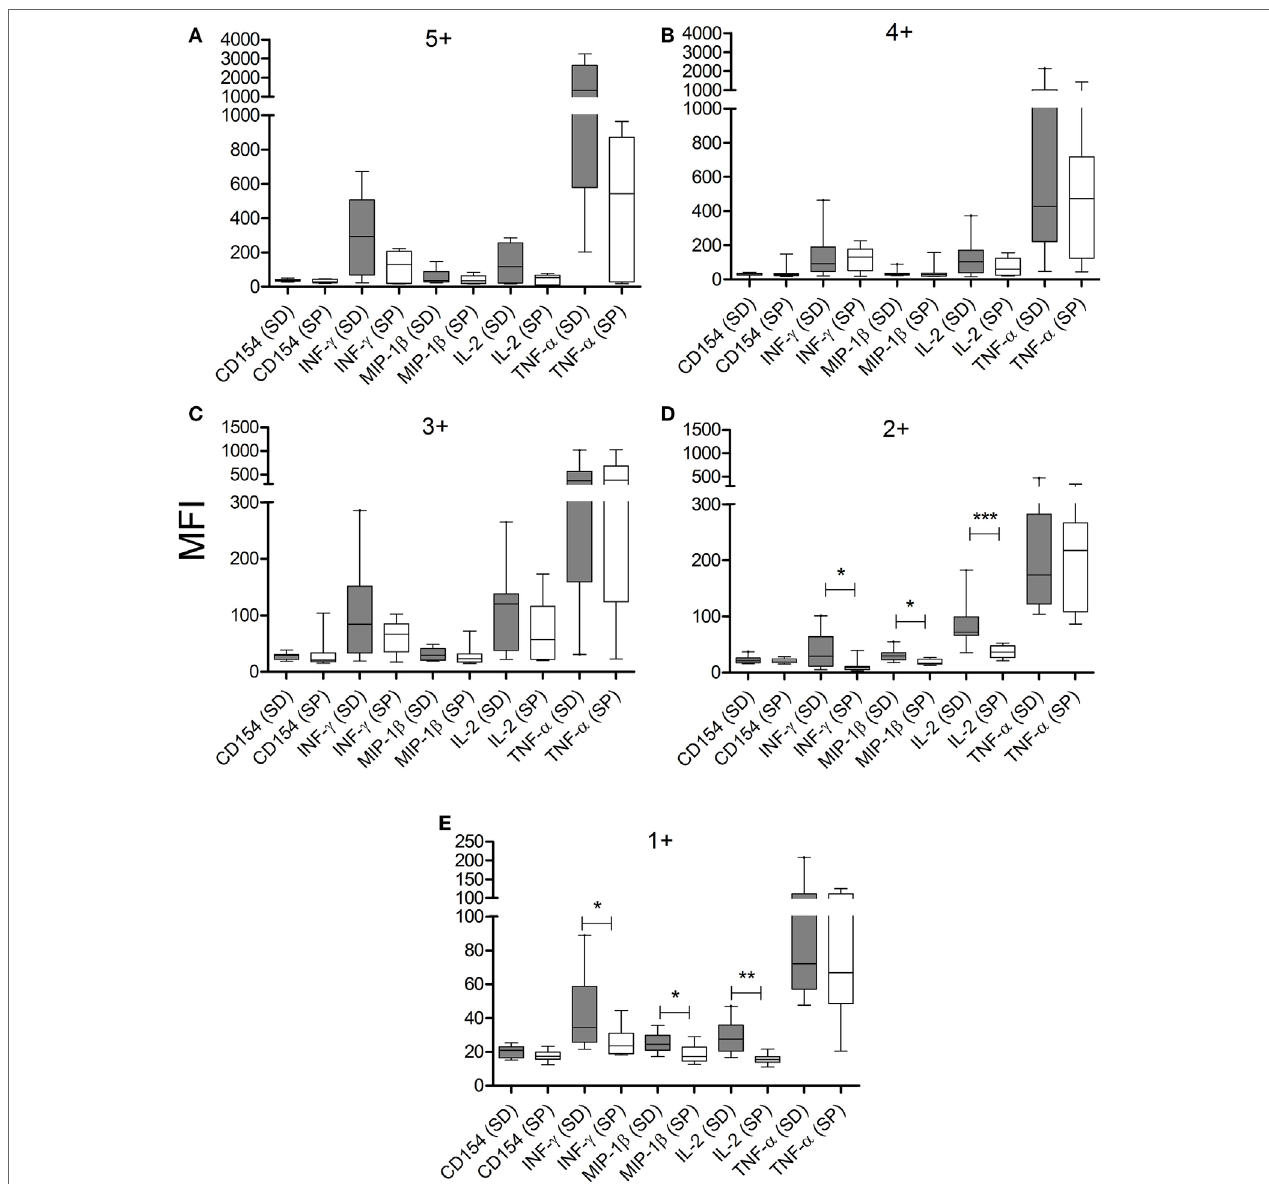
FigUre 4 | CD4 + T cells from serodiscordant subjects express higher amounts of cytokines than seropositive individuals in response to T. cruzi antigens. Peripheral blood mononuclear cells (PBMC) were stimulated with a T. cruzi lysate preparation from the Brazil strain and T. cruzi -specific CD4 T-cell responses were measured using an intracellular staining assay. The mean fluorescence intensity (MFI) of each cytokine for different cytokine coexpression subsets was analyzed. The median values and 10–90 percentile of MFI of each cytokine for CD4 + T cells with 5 + (a) , 4 + (B) , 3 + (c) , 2 + (D) , or 1 + (e) function were calculated. MFI of each cytokine was compared between serodiscordant and seropositive individuals by Mann–Whitney U test. (SD) Serodiscordant subjects; (SP) seropositive subjects. *** P < 0.001; ** P < 0.01; * P < 0.05 by Mann–Whitney U test or Student’s t -test.